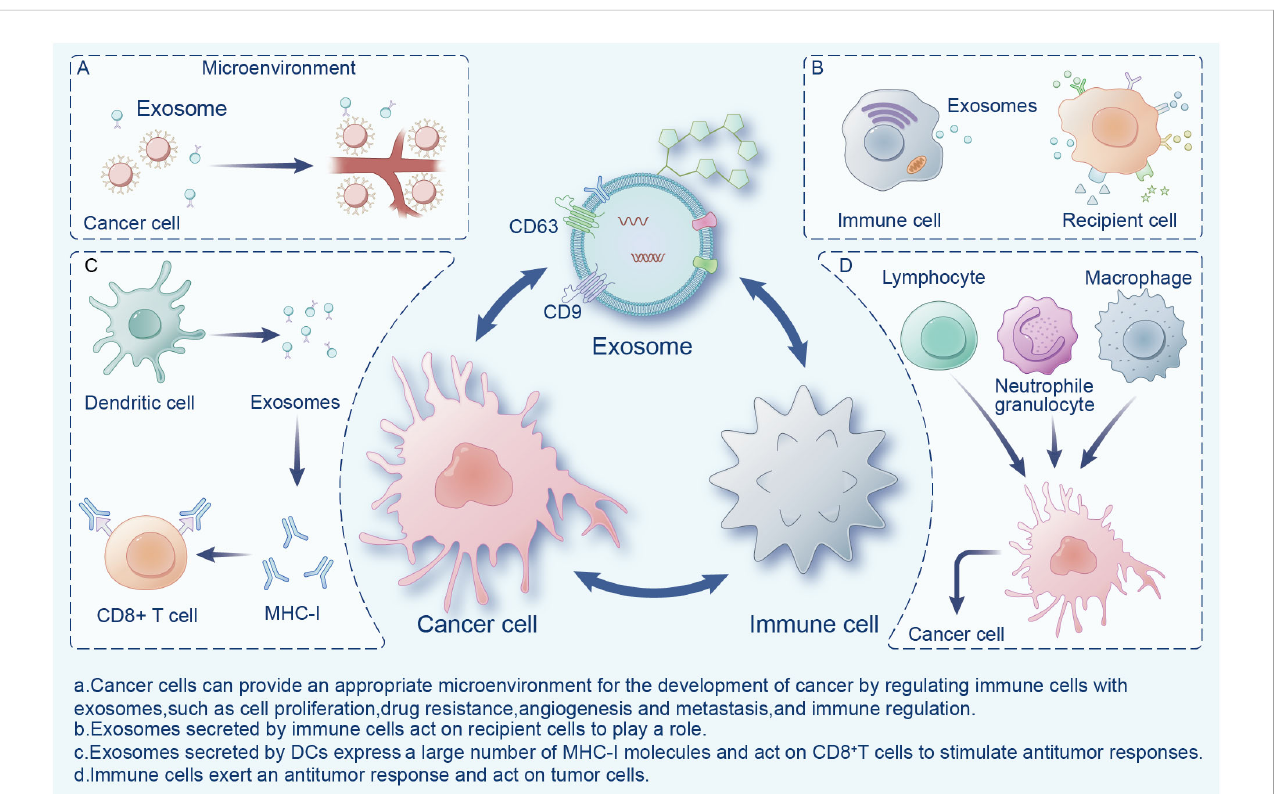
FIGURE 1 Interactions between exosomes, cancer cells, and immune cells in the tumor